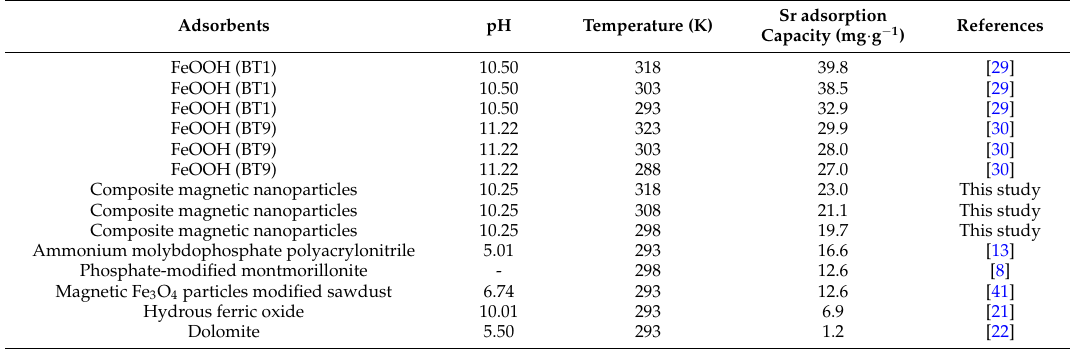
Table 3. Comparison of the Sr adsorption capacity among different adsorbents at various temperatures.